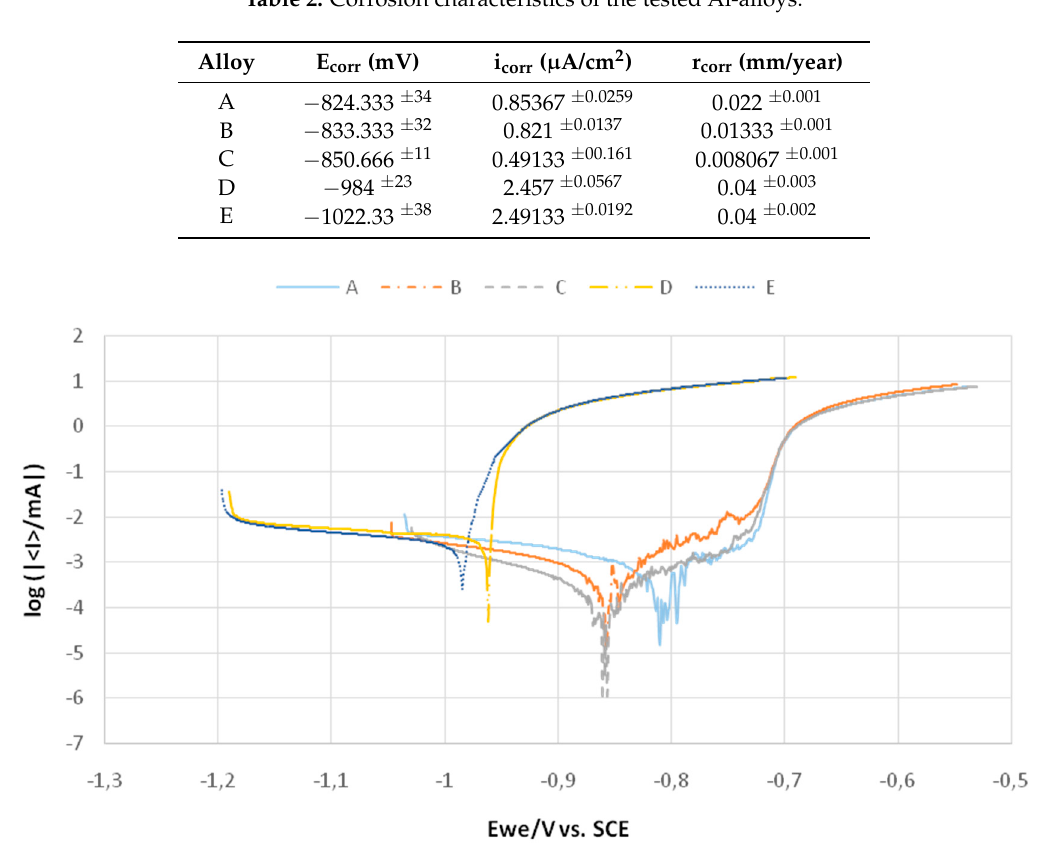
Table 2. Corrosion characteristics of the tested Al-alloys.